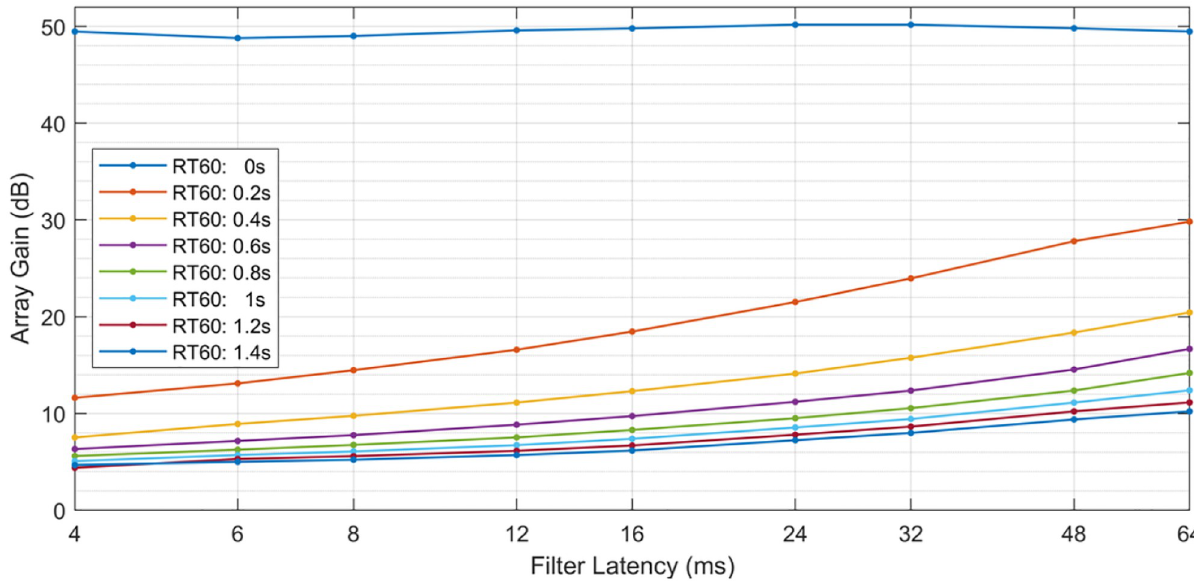
Fig 2. Filter latency vs. array gain. Increased filter length gives larger array gain at the expense of increased latency. Reverberation time by 60 dB (RT60) is given in the legend. (Filter latency = group delay = filter length � 0.5) Simulation for one desired source, two interfering